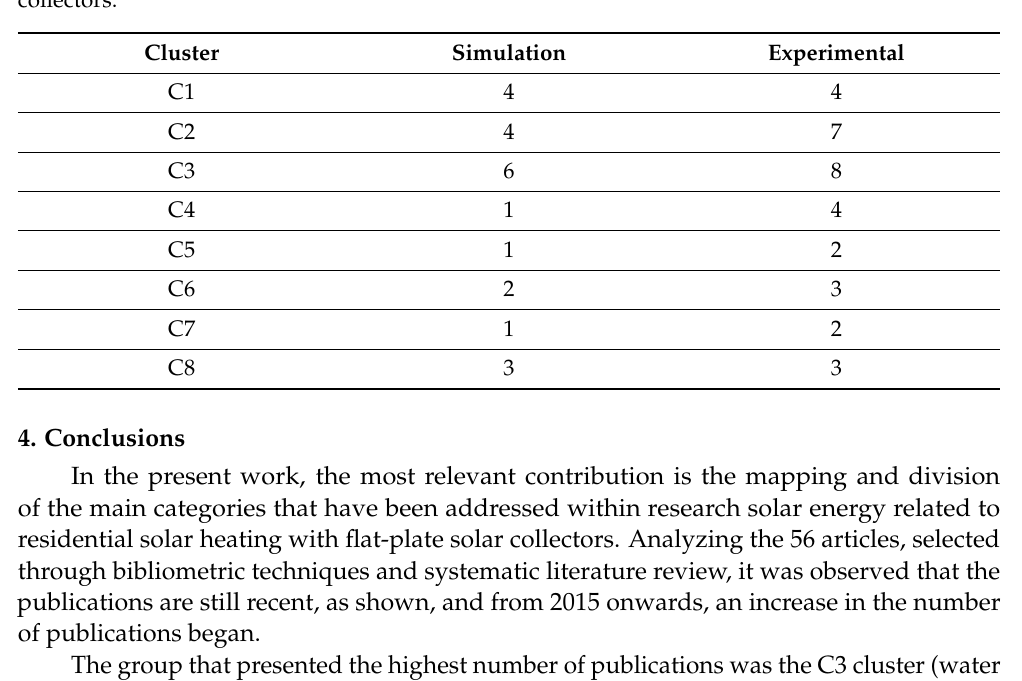
Table 2. Study method adopted by the authors of the residential solar heating sample with flat-plate